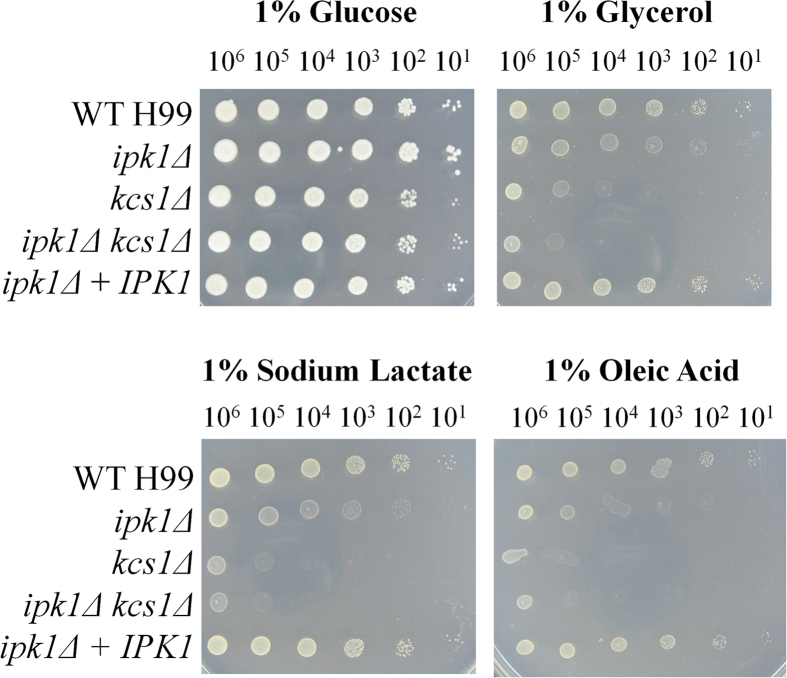
Effect of IPK1 deletion on alternative carbon source utilisation.All strains were serially-diluted 10-fold, from 106 cells to 101 cells per 3 μL (left to right) and dropped onto minimal media (MM) containing the carbon sources indicated. MM +1% glucose was used as a control. All plates were incubated at 30 °C for 72 hours.